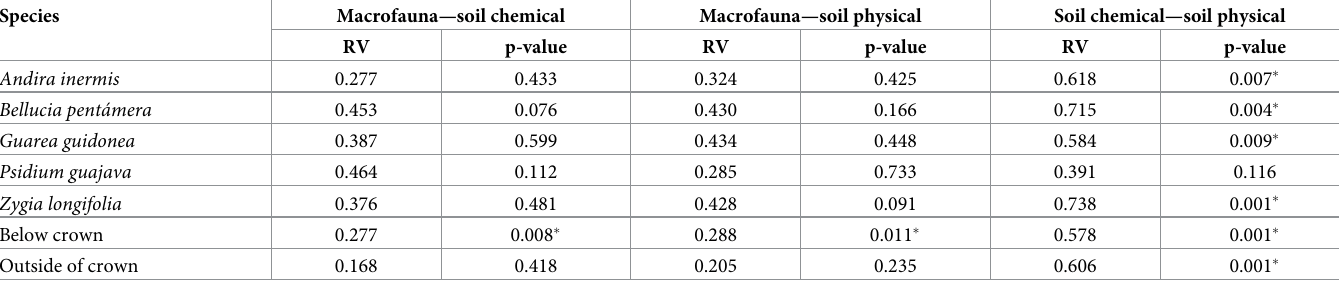
Table 4. Matrix coefficient (RV) between the three datasets for tree species and location. Species Macrofauna—soil chemical Macrofauna—soil physical Soil chemical—soil physical RV p-value RV p-value RV p-value Andira inermis 0.277 0.433